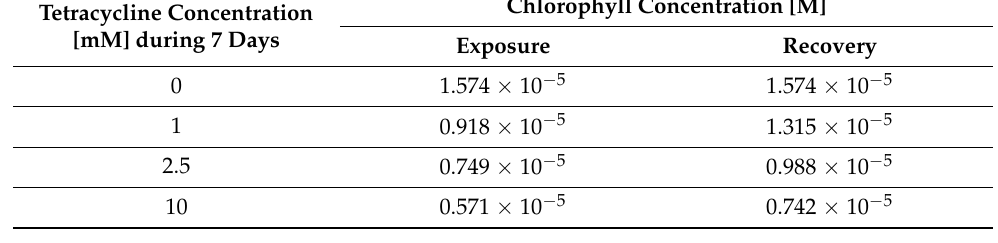
Table 2. Chlorophyll a content in Lemna minor subjected to tetracycline treatment (exposure) and in the recovery (resumed growth after 7 days of culture in antibiotic free medium).